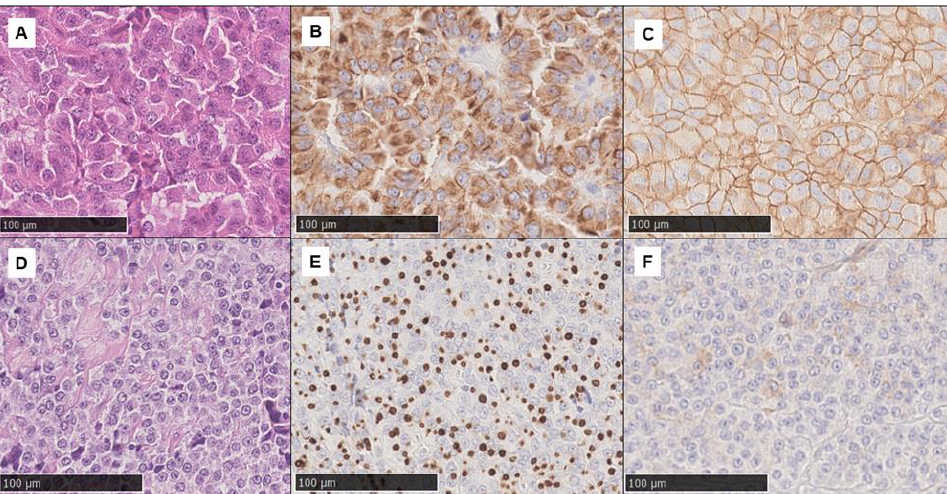
Figure 1. Histological images showing two example cases (original magnification 200 × ). The first set ( A – C ) shows a somatotroph adenoma ( A : hematoxylin and eosin) with a densely granulated CAM5.2 pattern ( B ) and diffuse SSTR2 positivity (score 3) ( C ). Conversely, the second set ( D – F ) shows a somatotroph adenoma ( D : hematoxylin and eosin) sparsely granulated according to the extensive dot-like CAM5.2 pattern ( E ) and with focal, mainly cytoplasmic, SSTR2 positivity (score 1) ( F